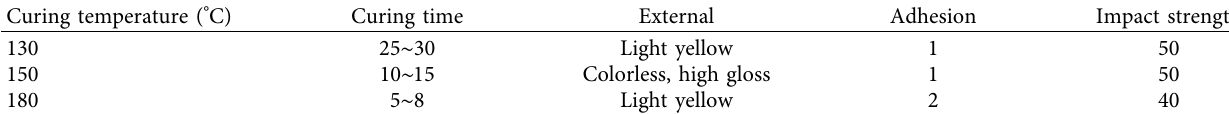
Table 5: Effect of curing temperature and time on film properties.